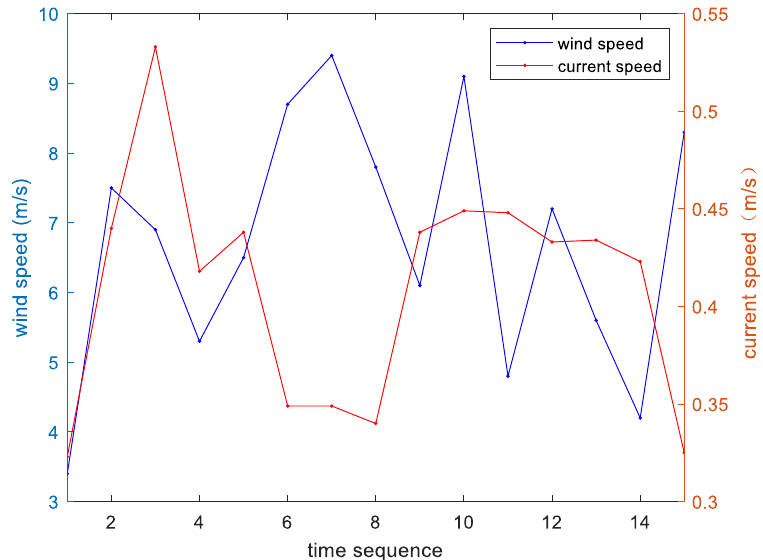
Figure 8. Ship working condition information.